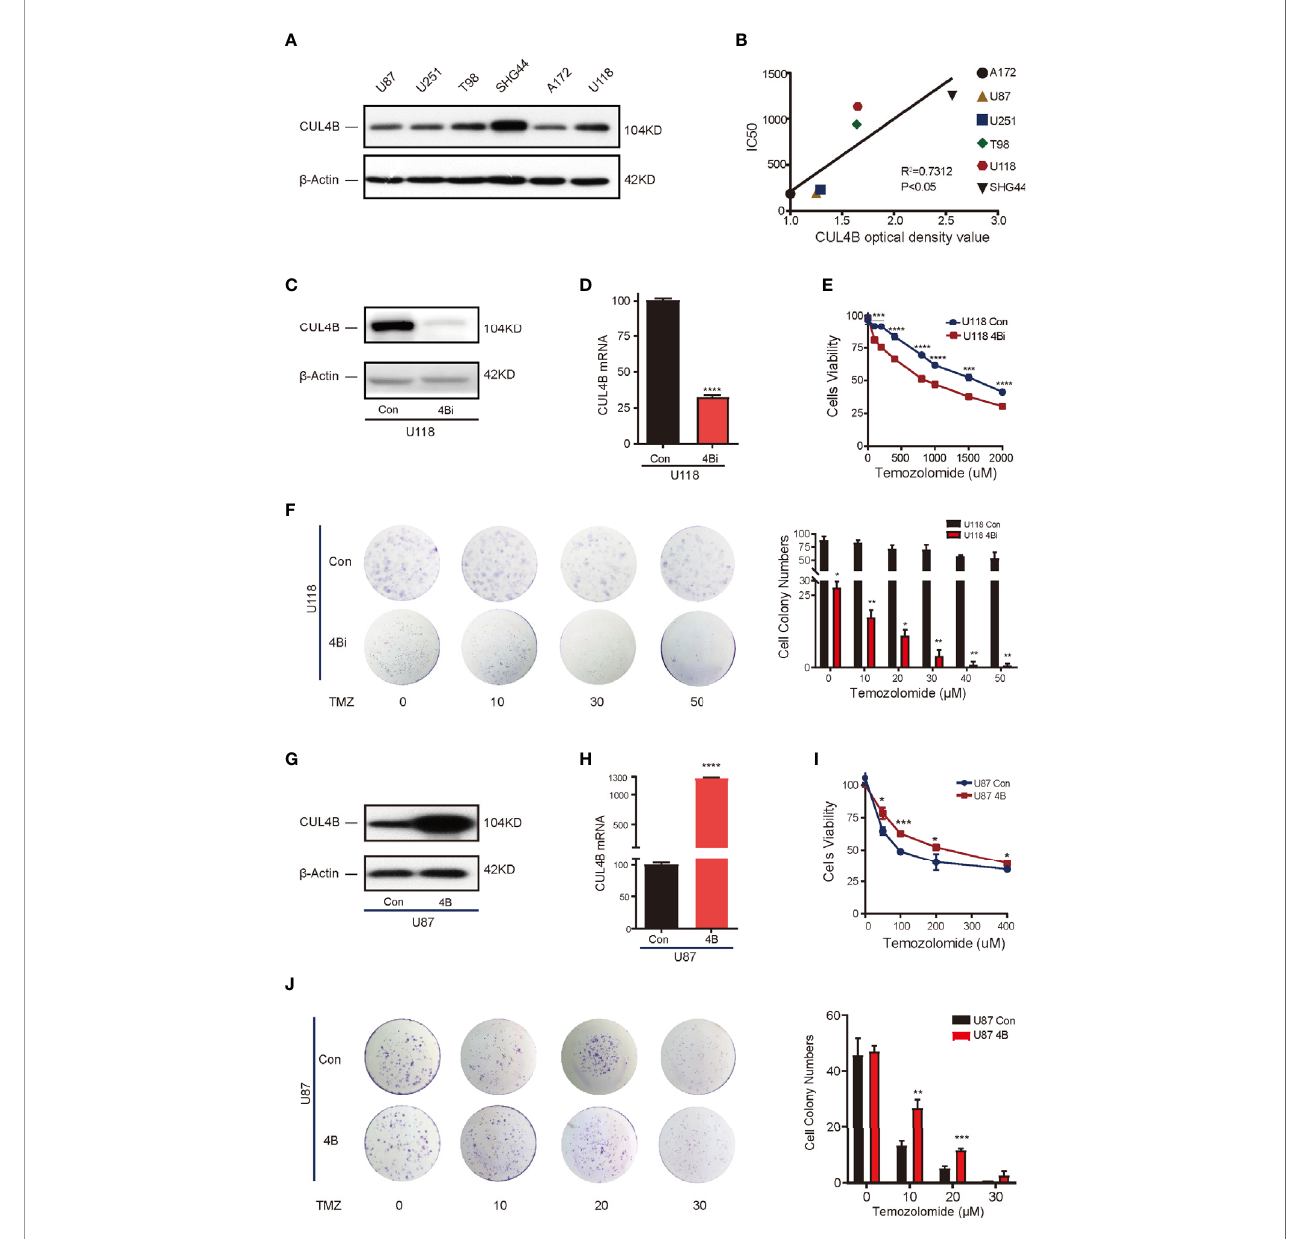
FIGURE 2 | CUL4B drives TMZ resistance in GBM cell lines. (A) CUL4B protein levels in indicated cell lines. (B) Linear regression analysis of CUL4B expression and IC50 of TMZ in indicated cell lines. (C, D) Knockdown ef fi ciency of CUL4B in U118 cells determined by Western blot (C) and qRT-PCR (D) . (E) Cell viability assessed in U118 CUL4B knockdown cells (U118 4Bi) and control (U118 Con) cells. (F) Representative images (left panels) and quanti fi cation (right panels) of the colony formation assays of U118 Con and 4Bi cells treated with different concentrations of TMZ. (G, H) CUL4B expression in indicated U87 cells was determined by Western blot (G) and qRT-PCR (H) . (I) Cell viability assessed in indicated U87 cells. (J) Representative images (left panels) and quanti fi cation (right panel) of the colony formation assays of indicated U87 cells treated with TMZ at different concentrations. (****P < 0.0001, ***P < 0.001, **P < 0.01, *P <